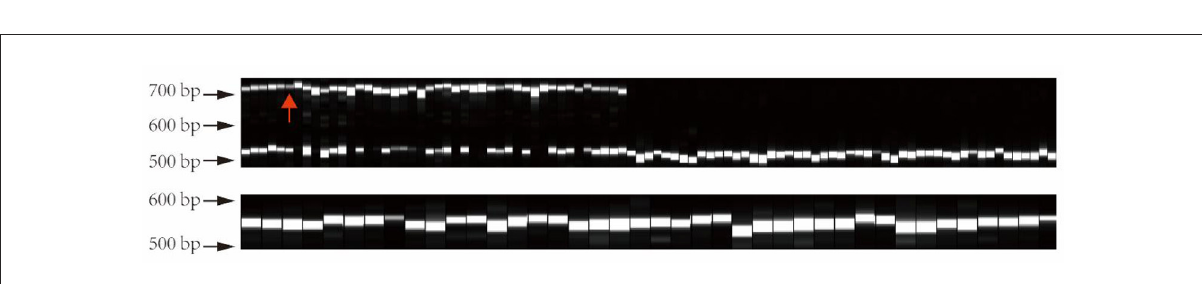
FIGURE10 Validation of structural variant genotypes in different tea plants by capillary electrophoresis. All large-leaf tea plants have a larger length allele. The red arrow indicates the “FoShou” variety.